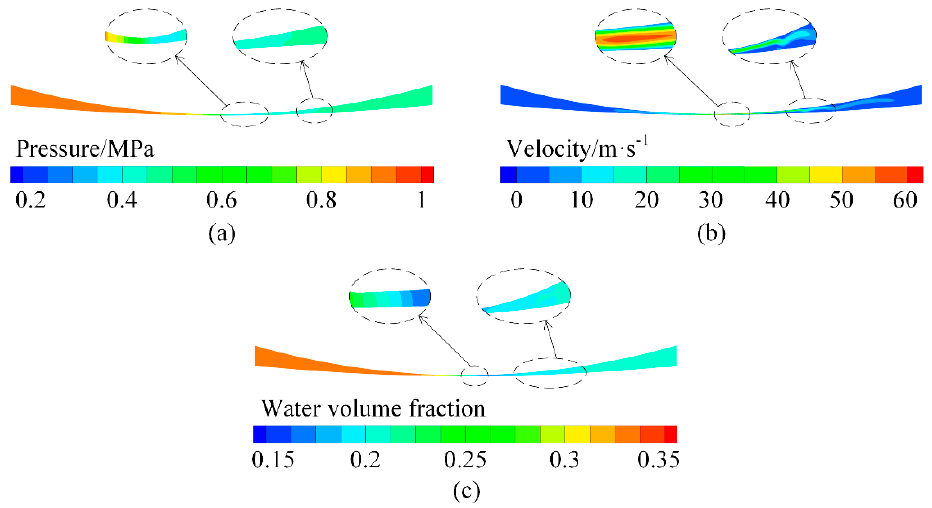
Figure 14. Pressure, velocity, and water volume fraction contours under the conditions of a pressure ratio of 2 and an inlet CO 2 volume fraction of 0.8 (not in scale). ( a ) pressure contours; ( b ) velocity contours; ( c ) water volume fraction contours.